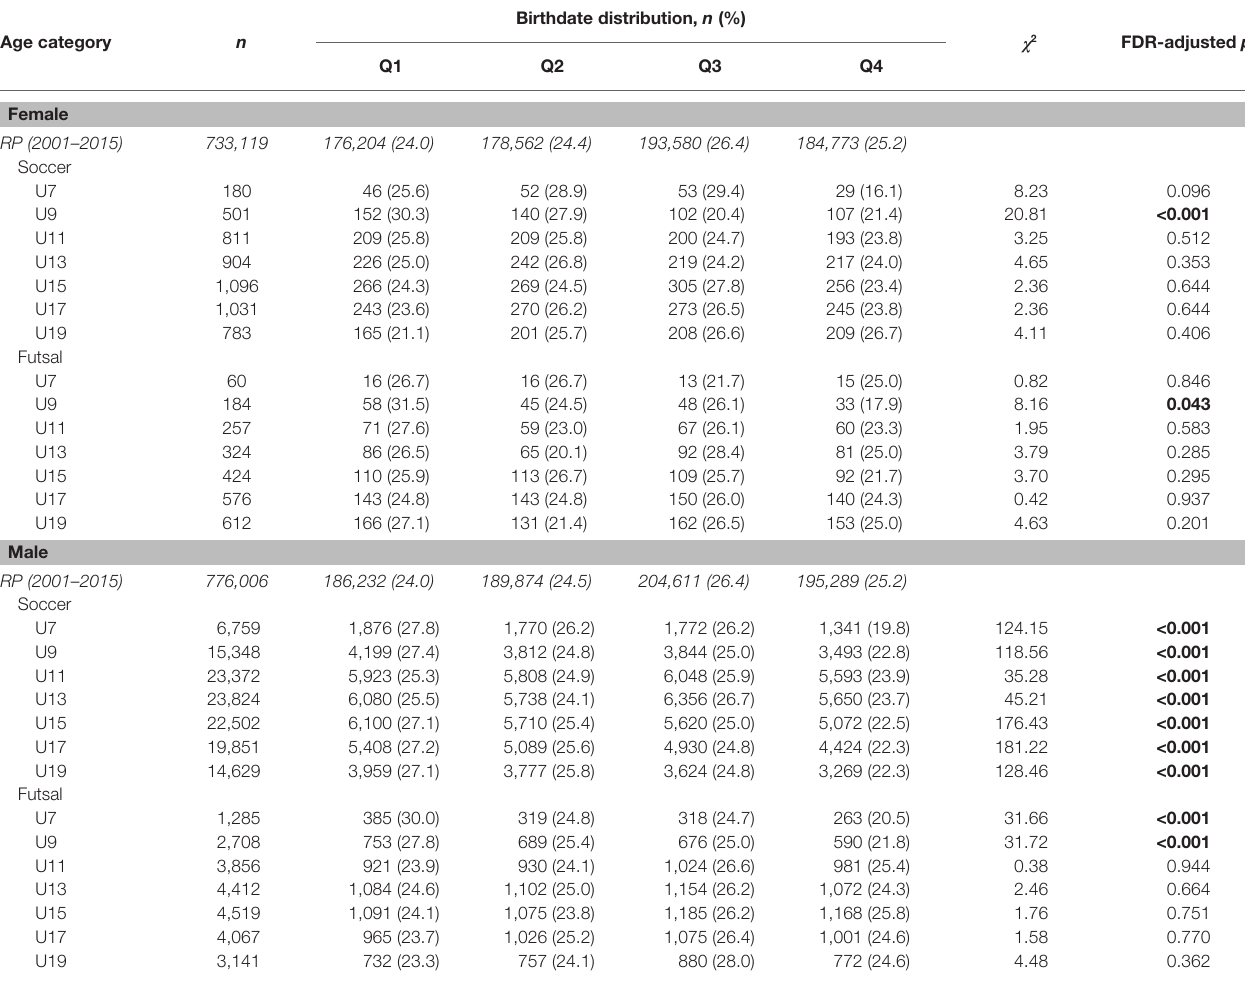
TABLE 1 | Birthdate distribution by quarter of the year for female and male youth soccer and futsal players registered with the Portuguese Football Association.